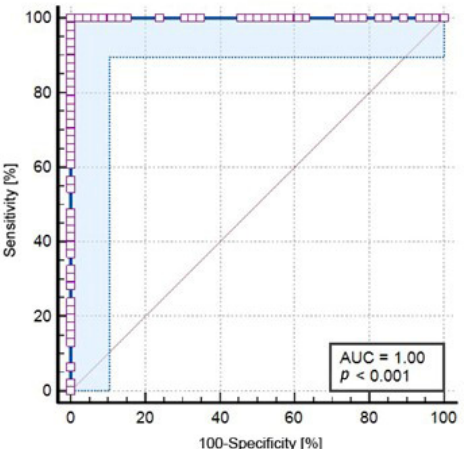
Figure 1. Receiver operating characteristic curve for LRG1 from human serum as a predictor of acute appendicitis (AUC = 1.00; 95% CI 0.96–1.00; p < 0.001). With a 7% prevalence of appendicitis in children assumed, a value of >69.1 µg/mL was determined as an optimal cut-off (Figure 2).